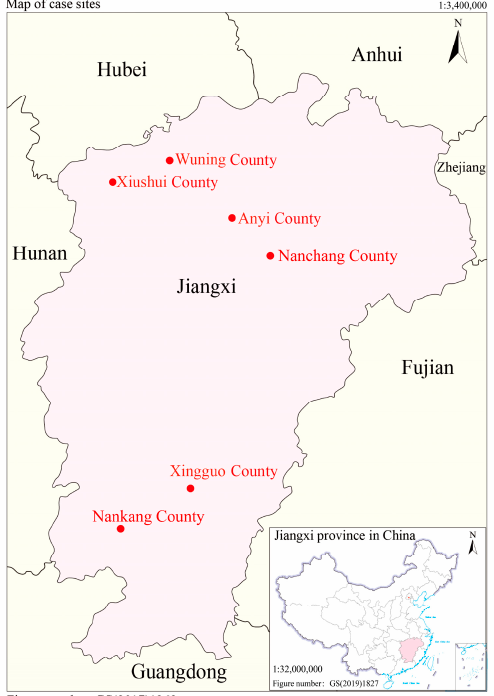
Figure 2. Location of the six case sites. Notes: these two maps are downloaded from http://bzdt.ch.mnr.gov.cn/ (accessed on 1 August 2022), without changing the boundaries. The figure numbers are GS(2017)1268, GS(2019)1827, respectively, the scales are 1:3,400,000, 1:32,000,000.